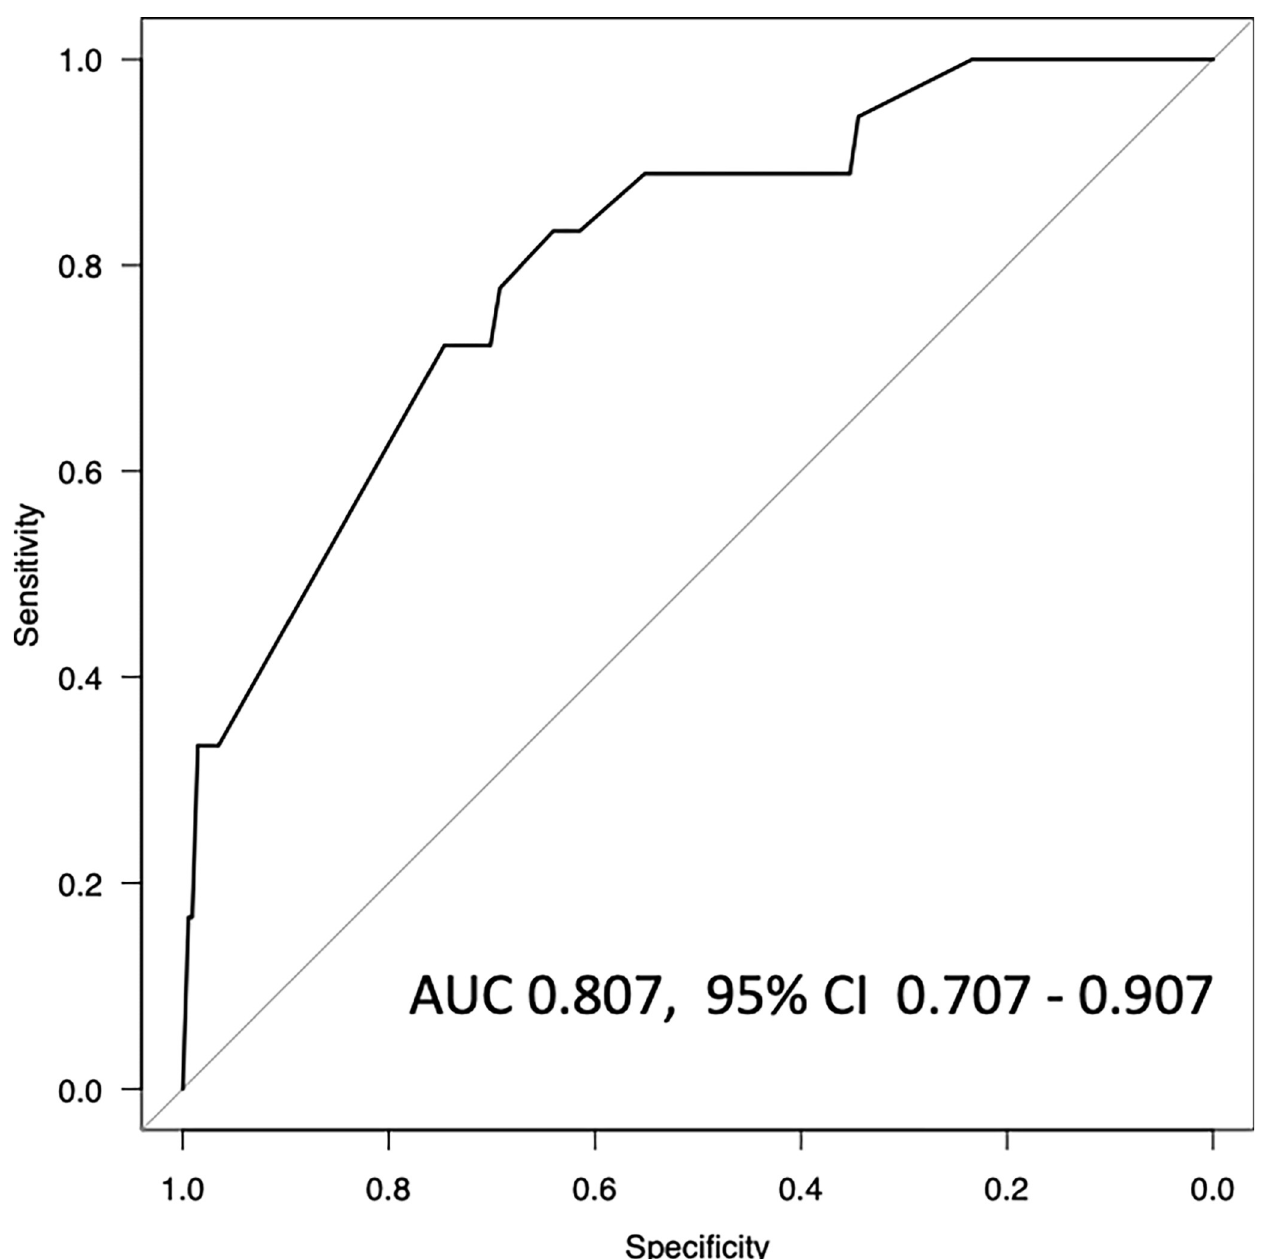
Fig 2. Area under the receiver operating characteristic curve (AUC) for the prediction of SARS-CoV-2 seropositivity of healthcare workers. The model was composed of only two factors of N95 mask implementation under possible aerosol conditions and working period in the hospital red zone section. AUC was 0 � 807 (95% CI 0 � 707–0 � 907). Note . AUC, area under the receiver operating characteristic curve; CI, confidence interval.